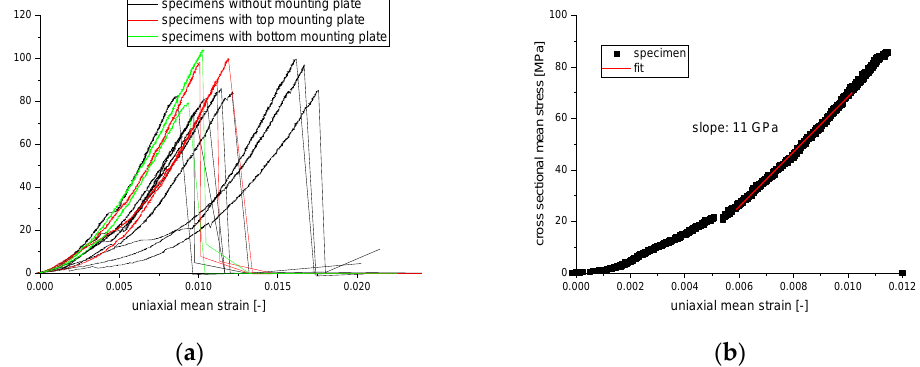
Figure 10. Results of uniaxial compression of a Si 3 N 4 -cylinder with SplitP TPMS structure: ( a ) ho- mogenized true stresses of the cross section and uniaxial mean strain by means of the dimensions; ( b ) fitted elasticity to stress-strain results.